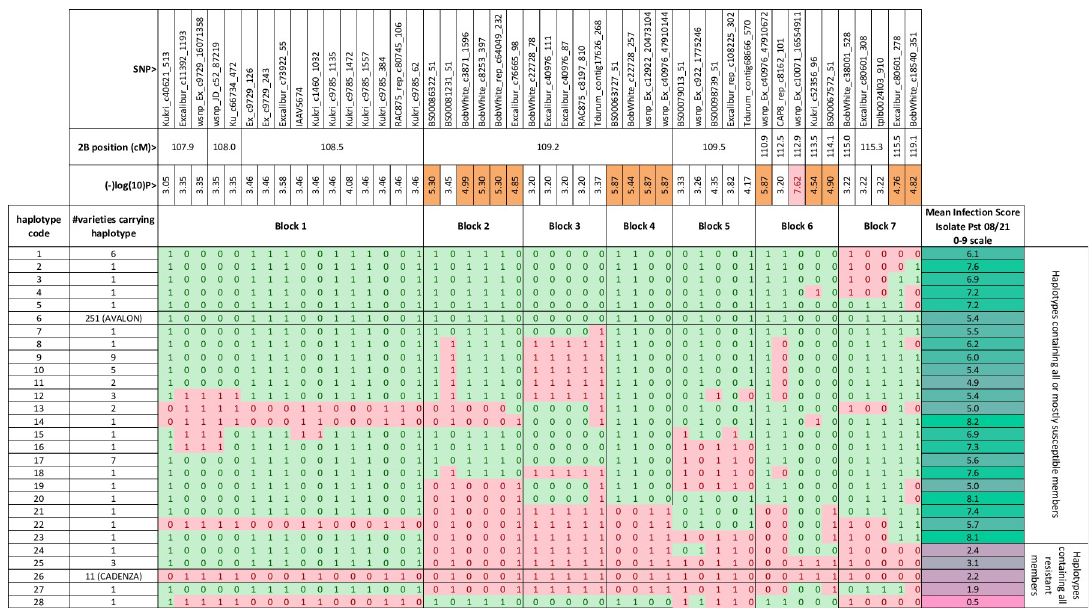
Fig 3. Haplotype structure of the Yr7 interval in the YR panel. The 28 distinct haplotypes formed by the 47 SNPs that span the Yr7 confidence interval are displayed in graphical genotype format. For each SNP, the SNP identifier, chromosomal position and P-value for the GWA scan with the Pst 08/21 (Avr-Yr7) isolate are shown.–log10(P)values above 4.5 are highlighted in orange and the most significant value, occurring at 113.8cM in Block 6, is highlighted in pink. The commonest susceptible haplotype (Haplotype 6 which includes ‘Avalon’ and 250 other varieties) is shaded in green and the most common resistant haplotype (Haplotype 26, which includes ‘Cadenza’ and 10 other varieties) is shaded in pink and all other haplotypes are coloured according to which alleles are shared with these reference haplotypes. Mean IF score from inoculation with Pst 08/21 is shown on the right highlighted according to a colour scale that goes from 0 –pink to 9 –green.